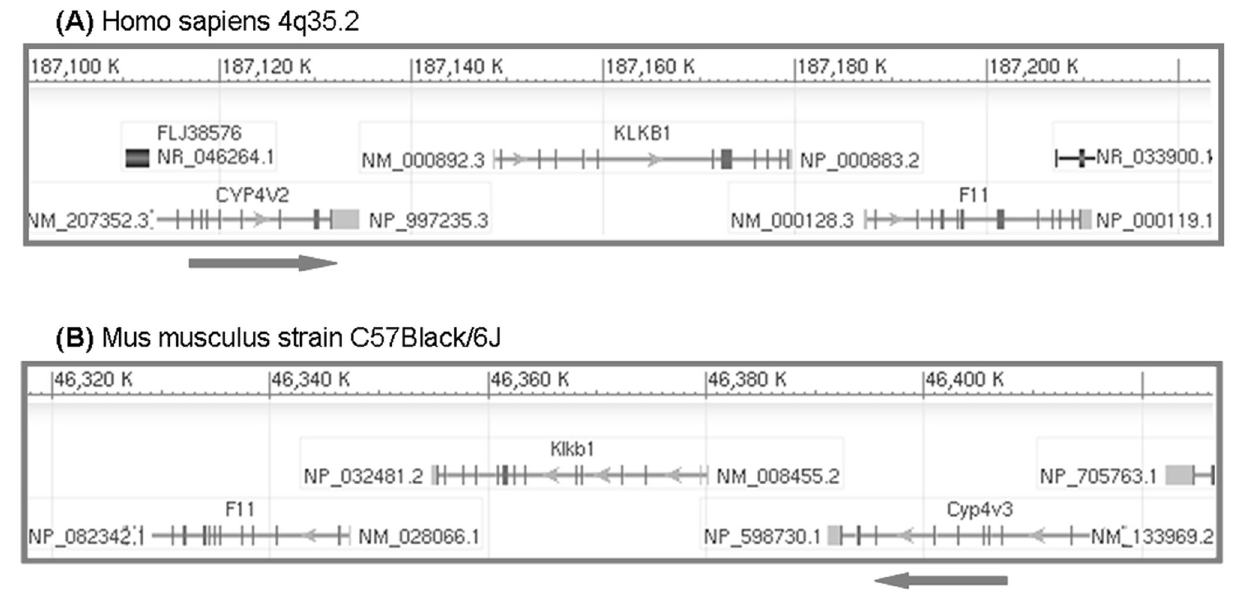
Figure 1. F11 gene locus organization in human (A) and mice (B). Vertical bars representing exons, and lines representing introns. Arrows show the orientation of transcription. Source; http://www.ncbi.nlm.nih.gov/. doi: